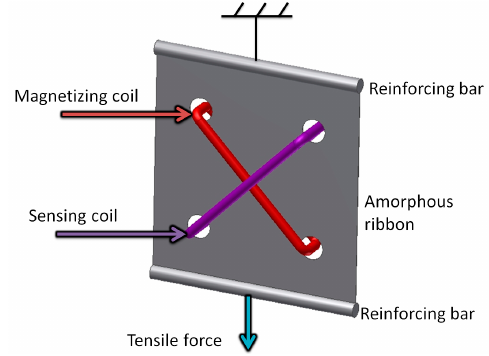
Figure 2. Schematic diagram of tensductor sensor.